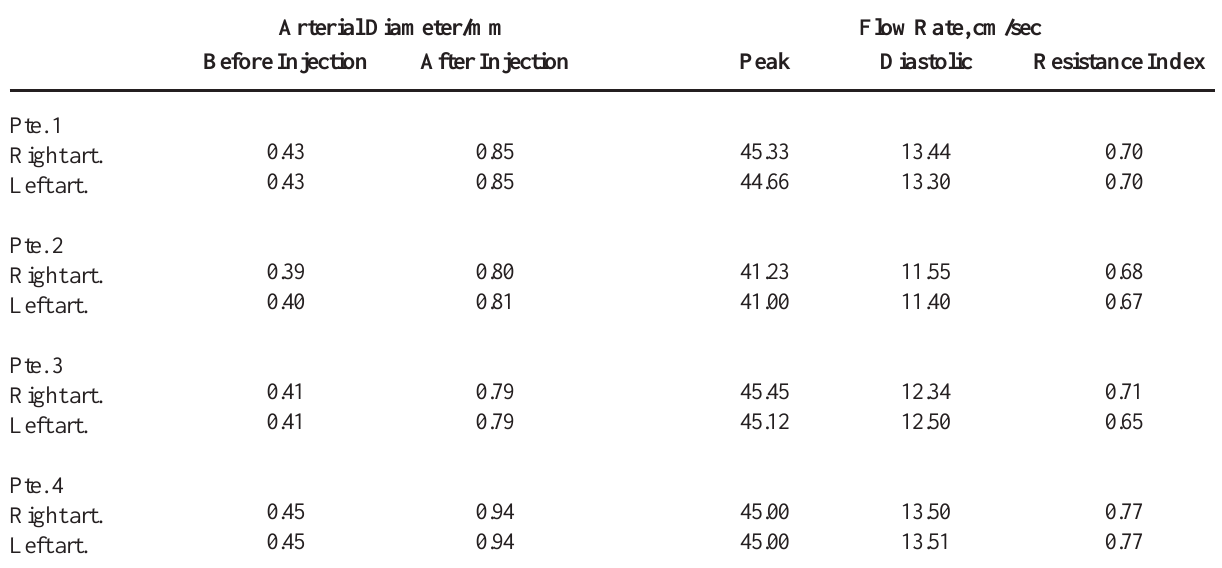
Table 2 – Echo Doppler flowmetry evaluation.